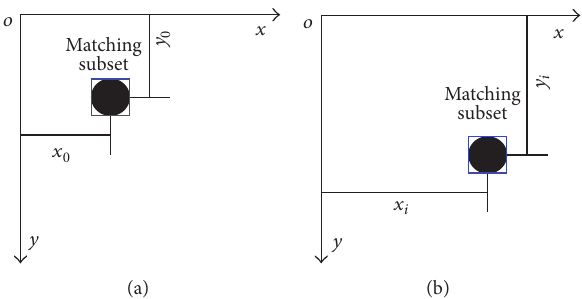
Figure 2: Schematic of change of target’s position: (a) initial stage; (b) deformation stage.